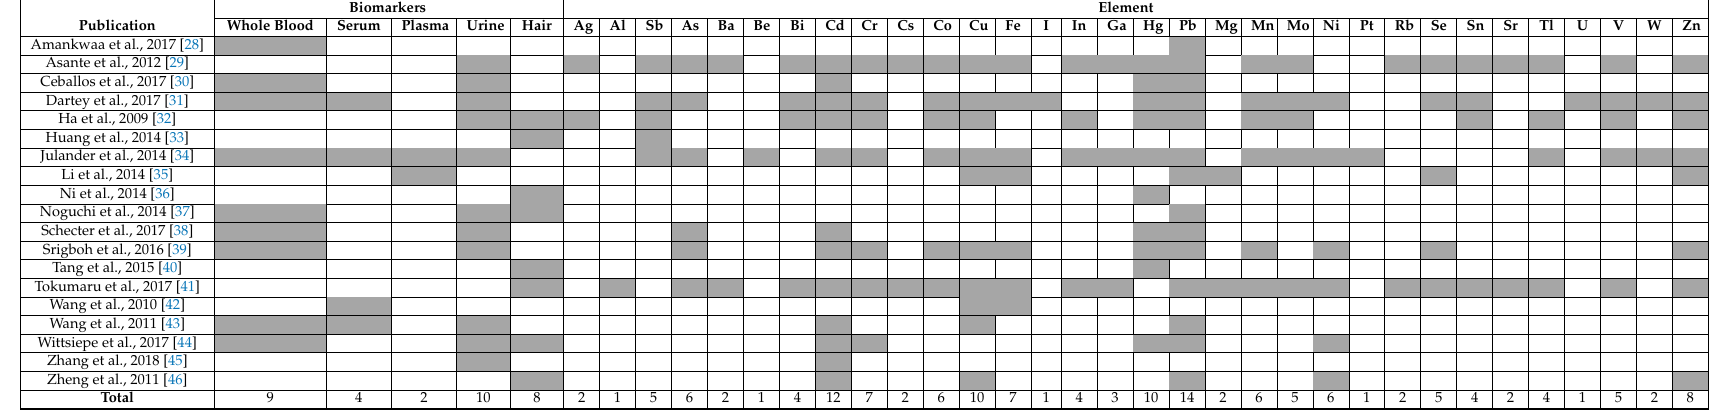
Table 1. Summary of biomarker measurement types for the study set including total values. Gray cells indicate the presence of biomarker or element in each study.